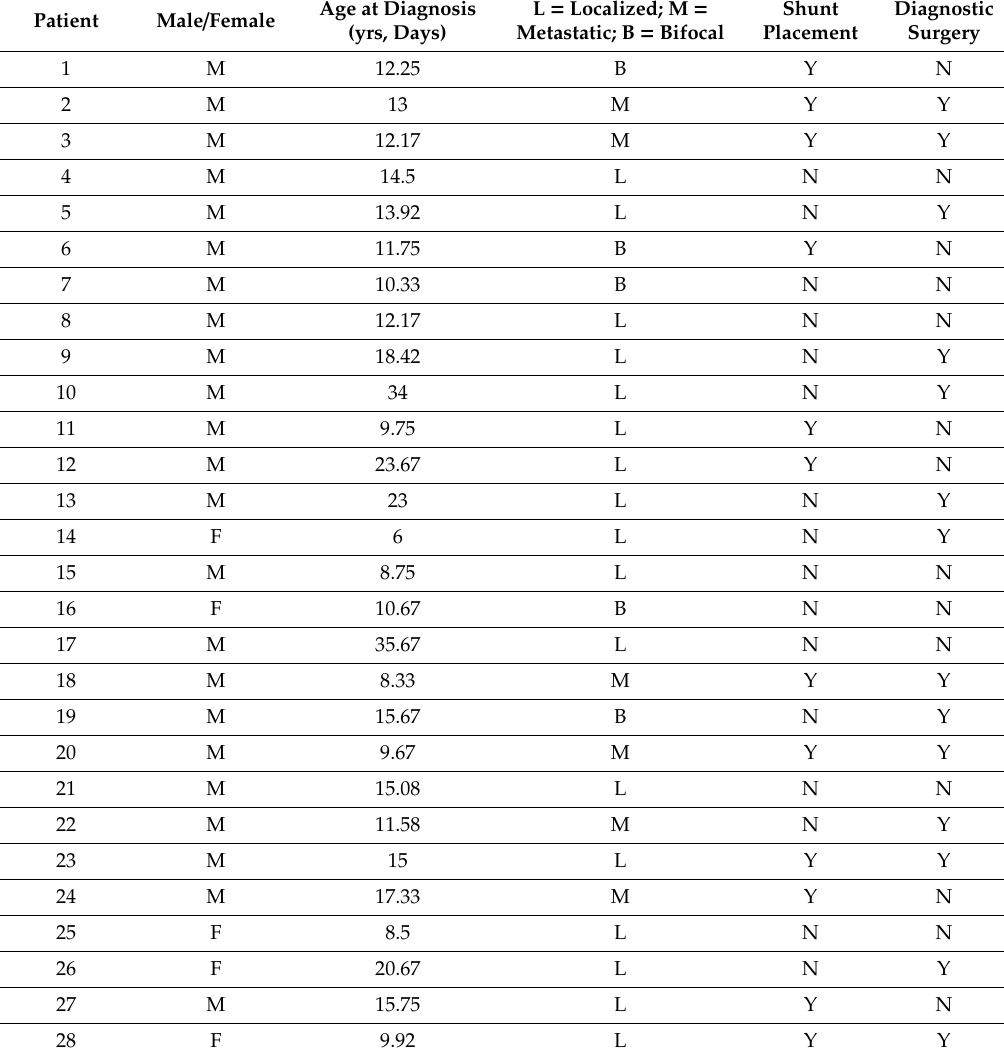
Table 1. Patients’